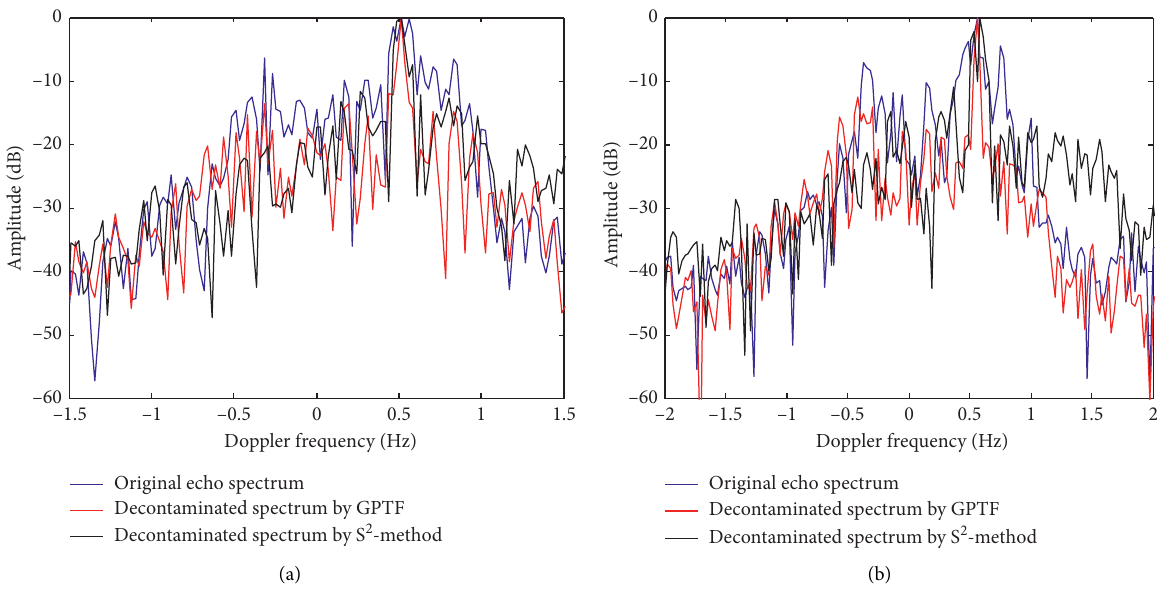
Figure 7: Decontamination results based on the GPTF method using the HF sky-wave radar. Decontamination result by the GPTF method (a) at range gate � 60 and azimuth angle DBF � 3 ° and (b) at range gate � 100 and azimuth angle DBF � 5 °